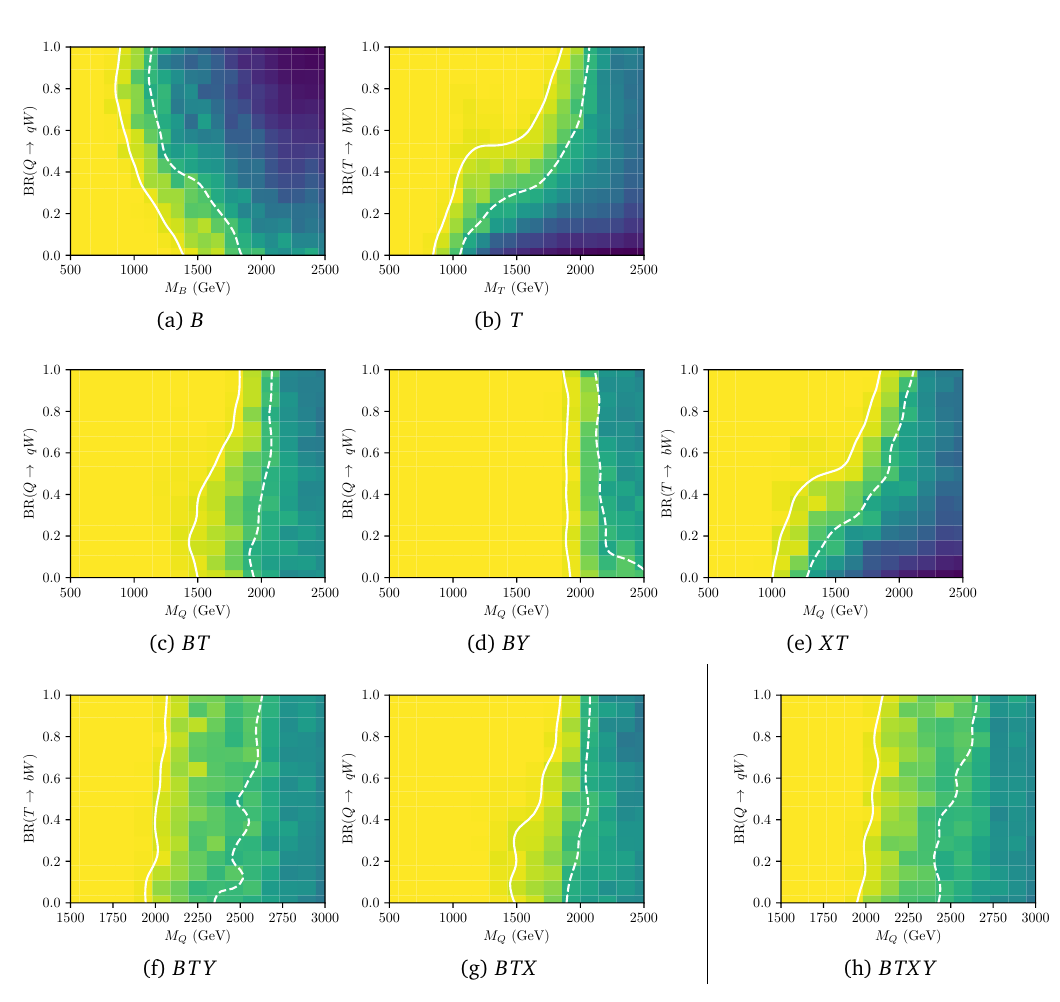
Figure 6: Sensitivity of LHC measurements to VLQ production when all VLQs are degenerate in mass, assuming BF ( Q → Hq ) = BF ( Q → Zq ) . The C ONTUR exclusion is shown in the bins in which it is evaluated, graduated from yellow through green to black on a linear scale, with the 95% CL (solid white) and 68% CL (dashed white) exclusion contours superimposed. The results for various multiplets are shown, in addition to the four-VLQ case which is unrealistic but still a useful benchmark. In the axis labels, Q may refer to B or T , while q may refer to b or t